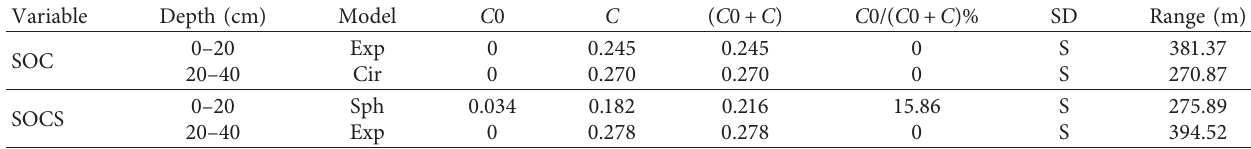
Table 5: The parameters of the semivariogram for the fitted models of the ordinary kriging (OK).